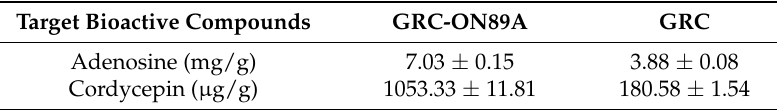
Table 1. Cordycepin and adenosine content in Cordyceps militaris grown on germinated Rhynchosia nulubilis (GRC) and GRC fermented with Pediococcus pentosaceus ON89A isolated from onion